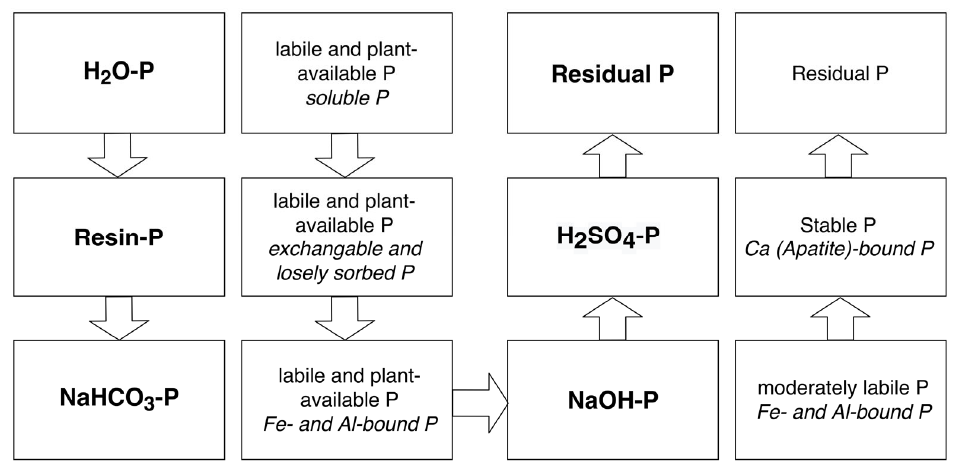
Figure 3. Hedley fractionation and the according phosphorus fractions. Adapted from